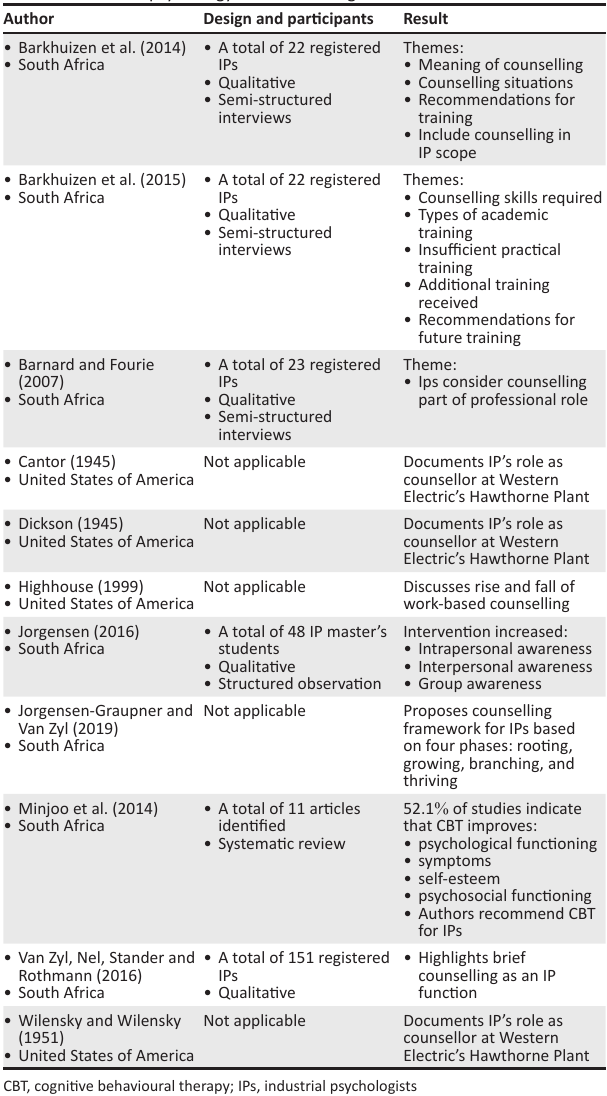
TABLE 1: Industrial psychology and